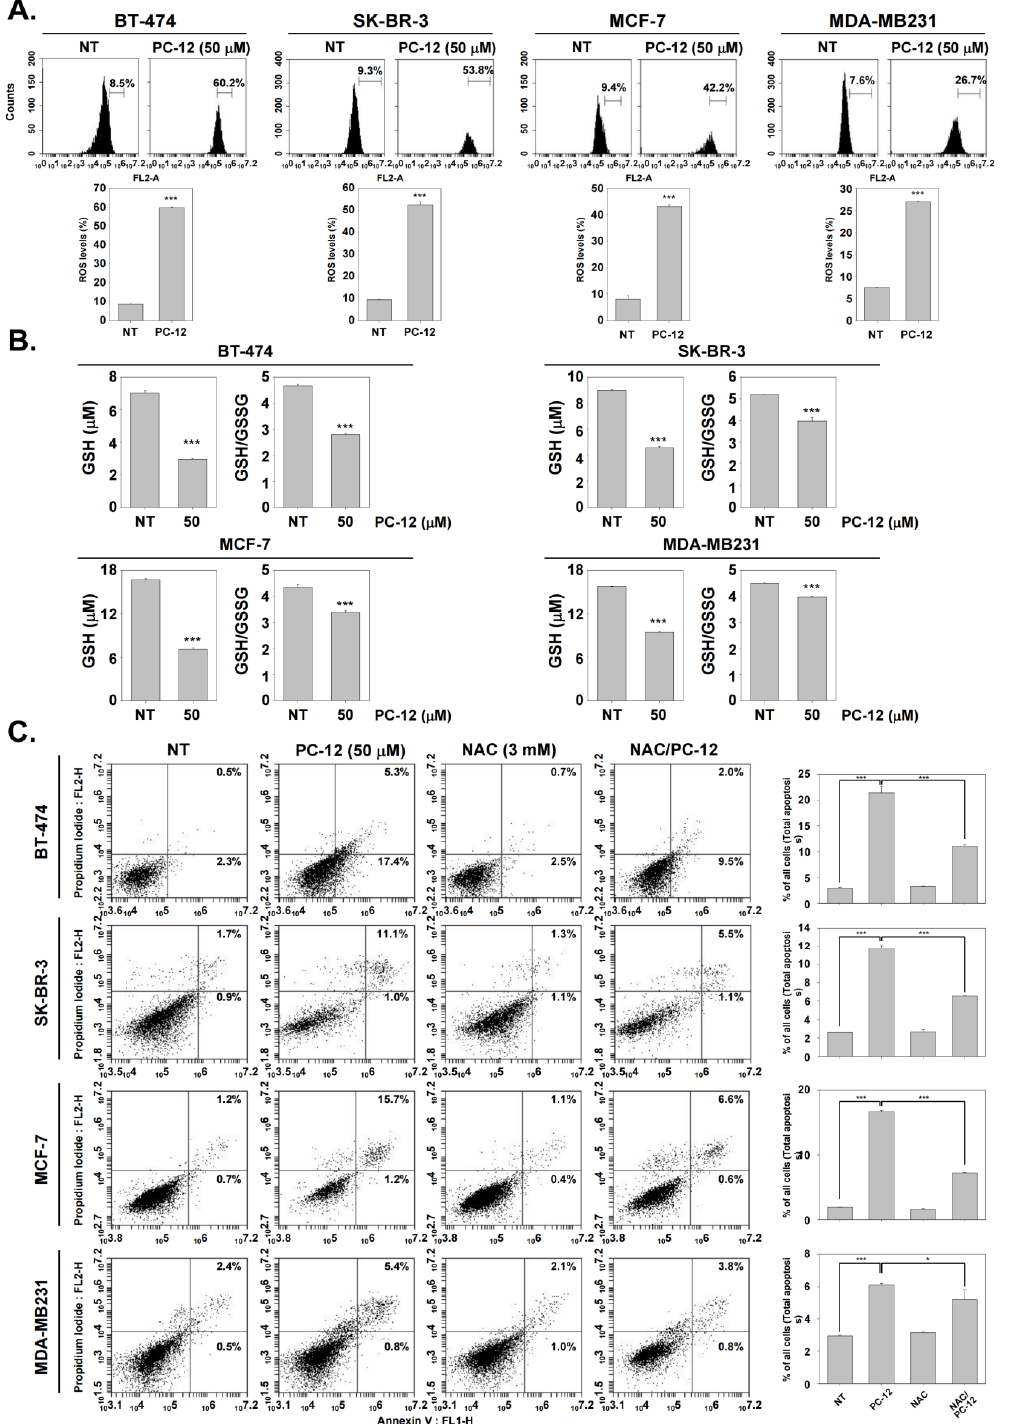
Figure 4. PC-12 induced apoptotic cells via ROS production. ( A ) PC-12 (0–50 µ M) treatment in four cell lines for 12 h. The cells were collected, and ROS measurement was performed using H2DCFH-DA staining. *** p < 0.001 vs. non-treated (NT) cells. ( B ) PC-12 (0–50 µ M) was incubated for 24 h with the four cell lines, and the GSH/GSSG assay was performed following the manufacturer’s protocol. *** p < 0.001 vs. non-treated (NT) cells. ( C ) BT-474, SK-BR-3, MCF-7, and MDA-MB231 cells were treated with 50 µ M of PC-12 or 3 mM of NAC for 24 h, an Annexin/PI staining assay was performed to measure apoptotic cells. *** p < 0.001 and * p < 0.05 vs. non-treated (NT)